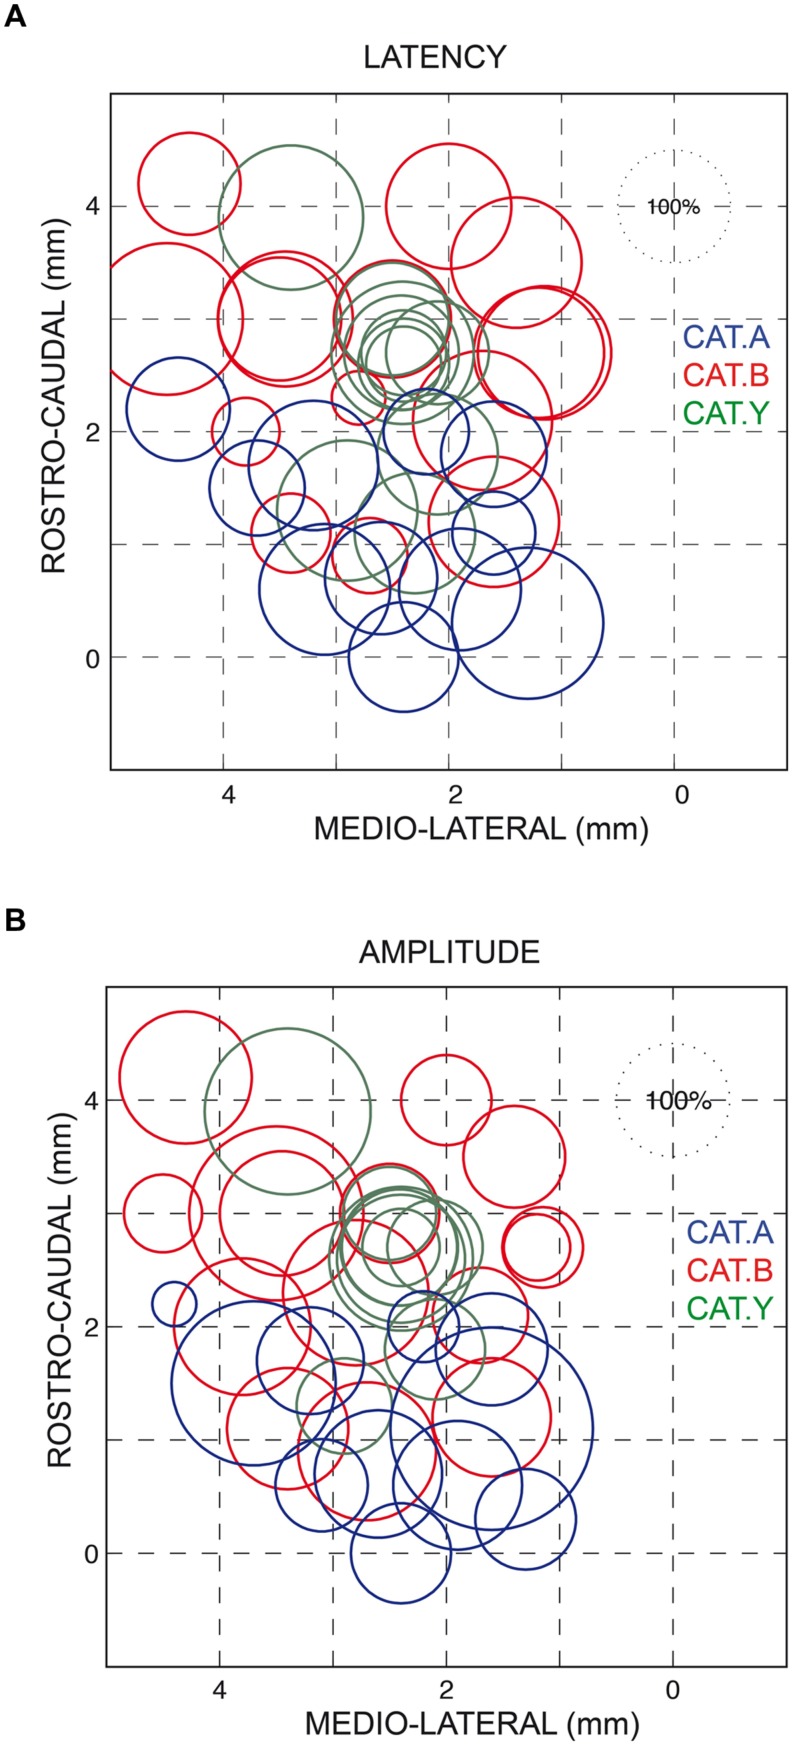
Normalized latencies (A) and amplitudes (B) of the forelimb movement perturbations following SC electrical stimulation plotted on a dorsal view of the left SC. The diameter of the circles represents the latency/amplitude of the perturbation expressed as a percentage of the average value computed for all three cats (100% circle in the upper right corner of each figure). The horizontal and vertical axes represent the stereotaxic coordinates, expressed in mm, along the medial-lateral and rostral-caudal axes, respectively. Each cat is identified by the same color as in Figure 1.